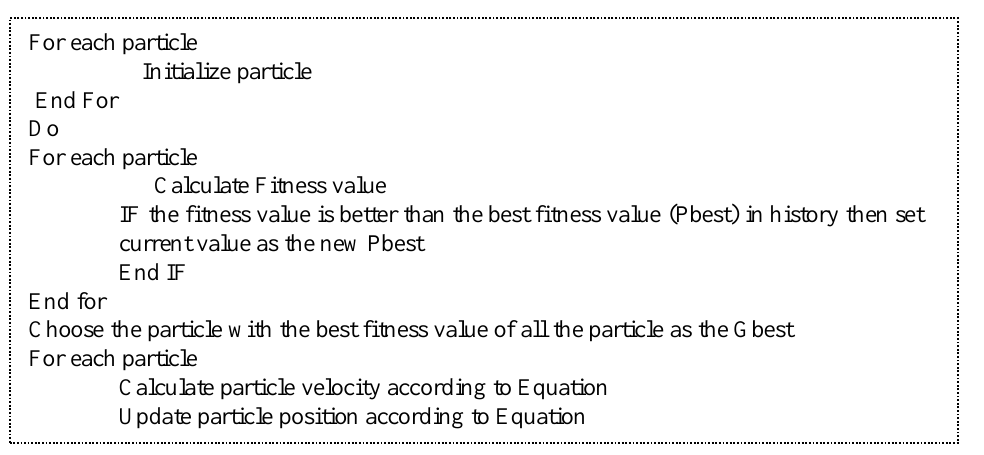
Figure 5. Particle Swarm Optimization source